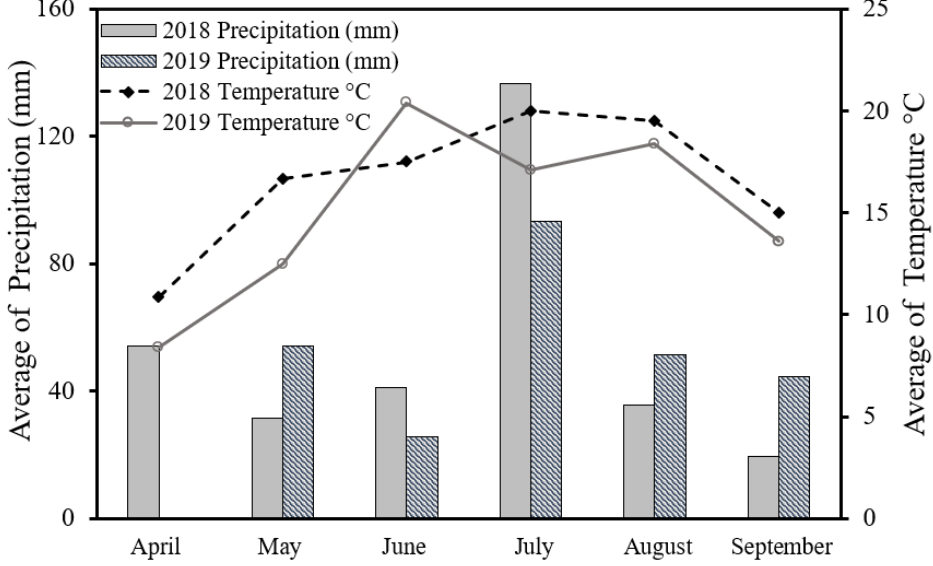
Figure 1. Mean monthly temperatures °C and precipitation (mm) during the growing maize season for the 2 years study (2018 – 2019).